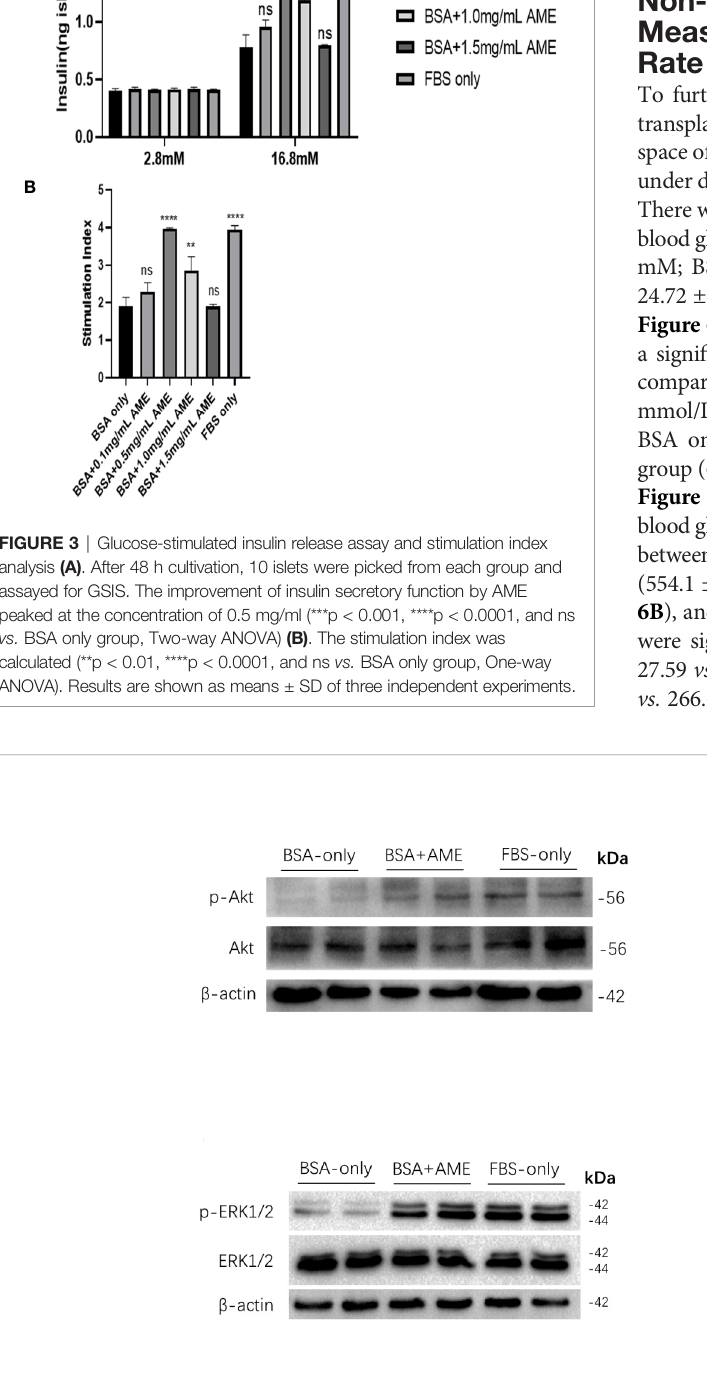
FIGURE 4 | AME increased the phosphorylation of Akt and ERK1/2. (A, C) Protein levels of p-Akt, Akt, p-ERK1/2, and ERK1/2 were assessed by Western Blot (B) . and (D) Quanti fi cation of protein levels showed the enhanced expression of Akt and ERK1/2 after AME (0.5 mg/ml) treatment (**p < 0.01 and ***p < 0.001 compared to BSA only group, One-way ANOVA). Results are shown as means ± SD of three independent